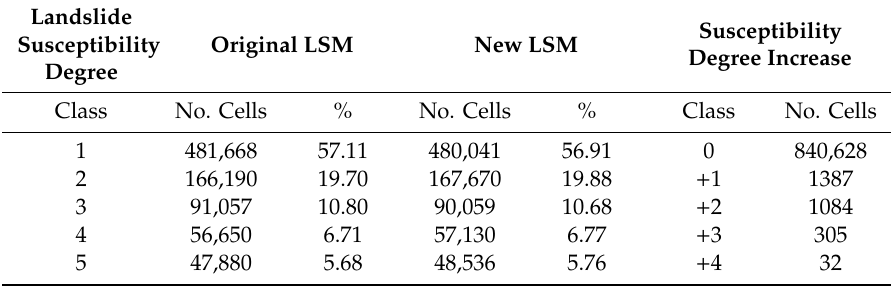
Figure 8. ( a ) New landslide susceptibility mapping results after the application of the correction matrix. ( b ) Difference between the original landslide susceptibility degree and the new landslide susceptibility degree for each cell. The circled areas labelled 1-3 correspond, respectively, to the Blumkou Reservoir, the Muztag Mountains, and an area of mining activity. Table 4. Comparison of the original landslide susceptibility assessment degrees with the revised degrees after correction.